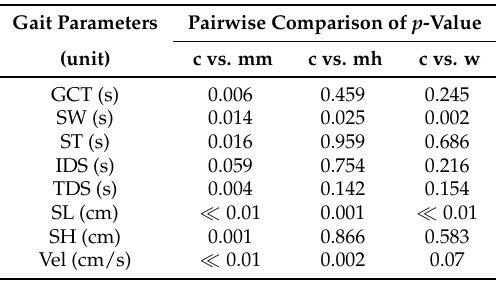
Table 5. p -values for the pairwise comparison of gait parameters for PD subjects walking without and with motorized